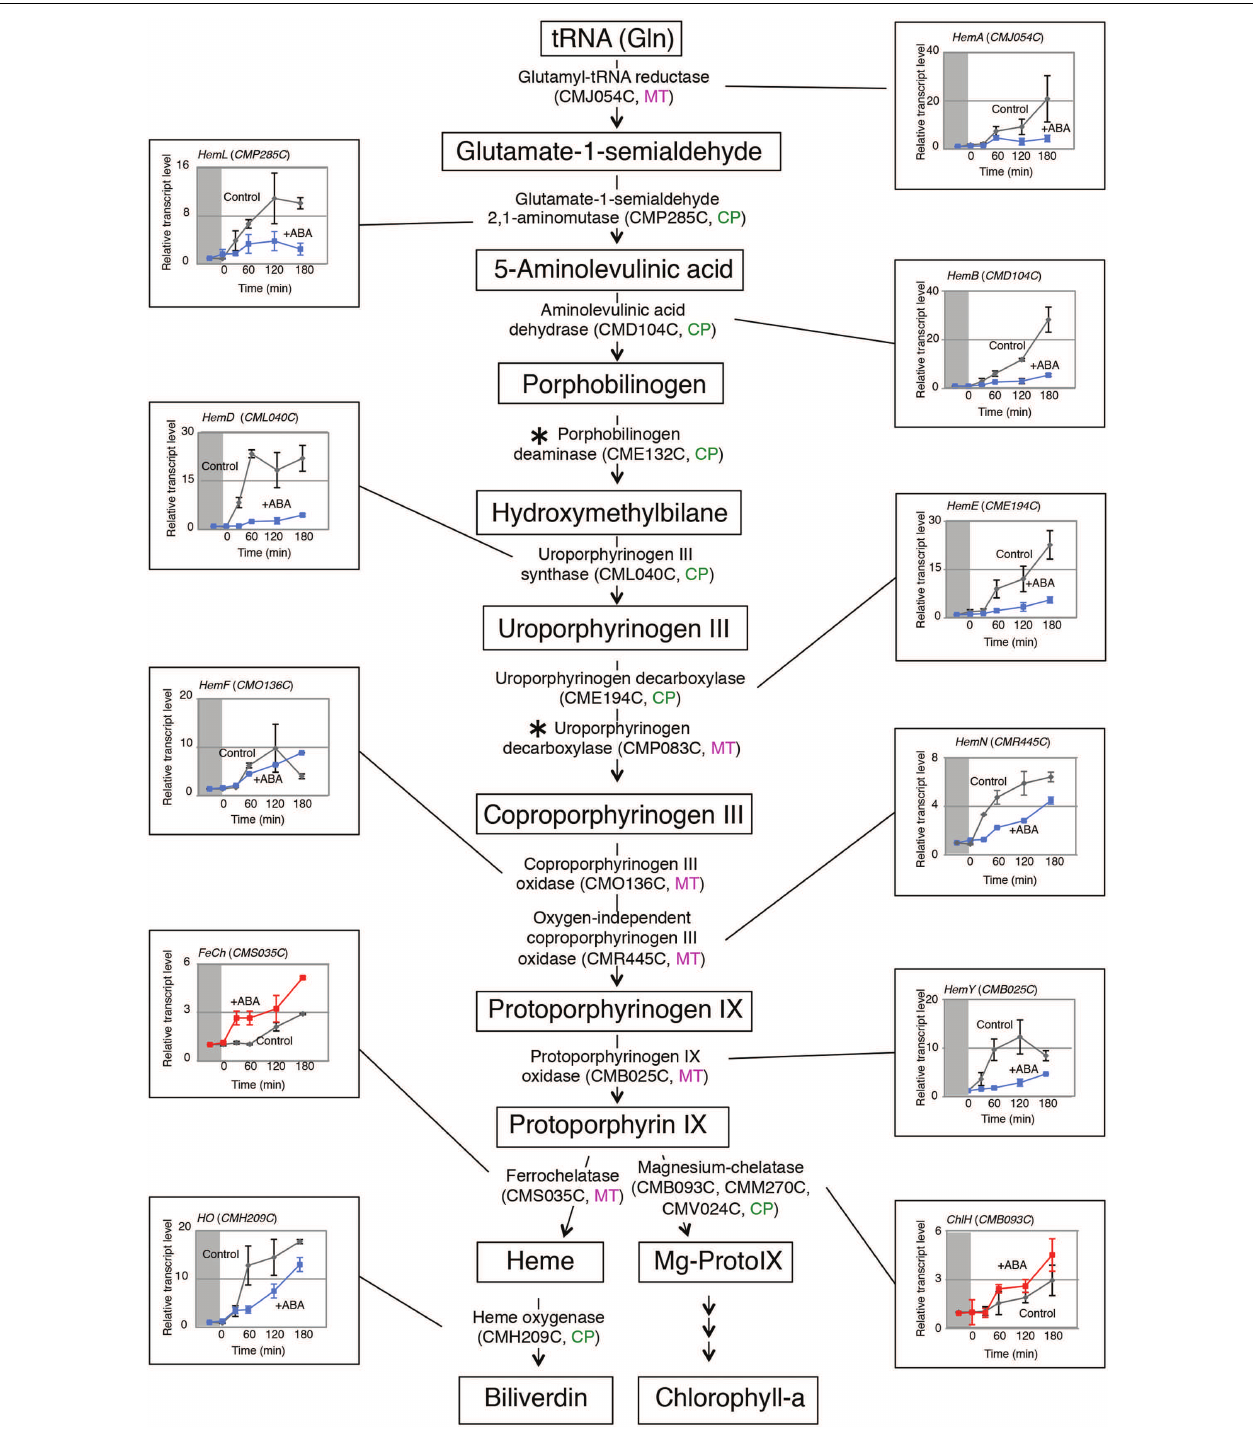
FIGURE 1 | ABA affected the accumulation of heme-related gene transcripts. The tetrapyrrole biosynthetic pathway is schematically represented. C. merolae cells were dark adapted for 16 h, and the transcript accumulation for each gene was monitored after illumination by quantitative PCR in the absence or presence of ABA. Cells were sampled at the indicated times, and ABA (10 µ M) was added 30 min before the light illumination. Data represent the average of three independent experiments ( n = 3 SD ). Boxes indicate tetrapyrrole intermediates, and the localization of each enzyme is indicated as in the mitochondrion (MT) or chloroplast (CP) as predicted (Watanabe et al., 2013). The light-dependent increase in the transcript levels were repressed (blue) or activated (red) by ABA addition. Asterisks indicate genes whose transcripts were not detected by the quantitative PCR analysis.